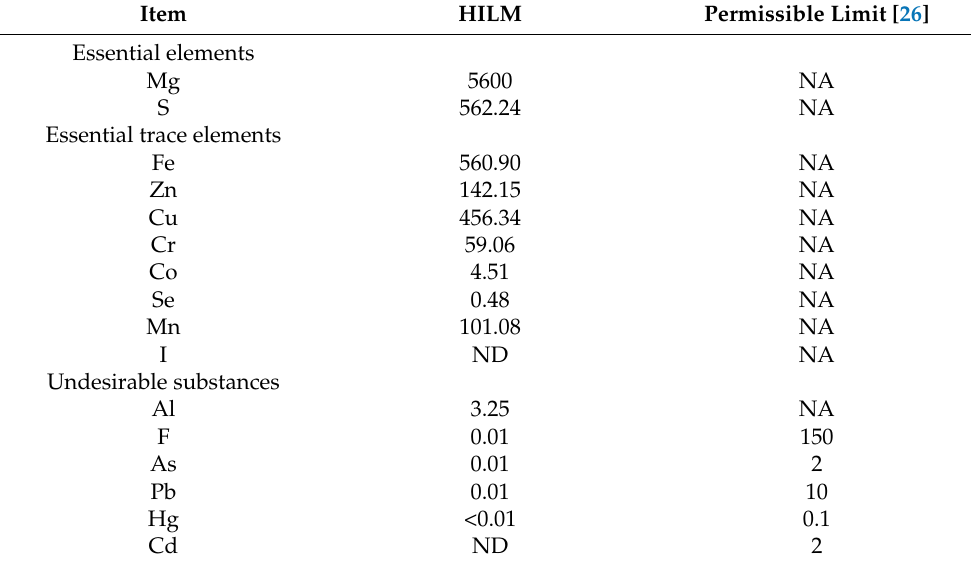
Table 8. Heavy metal concentration (mg/kg) in Hermetia illucens larvae meal